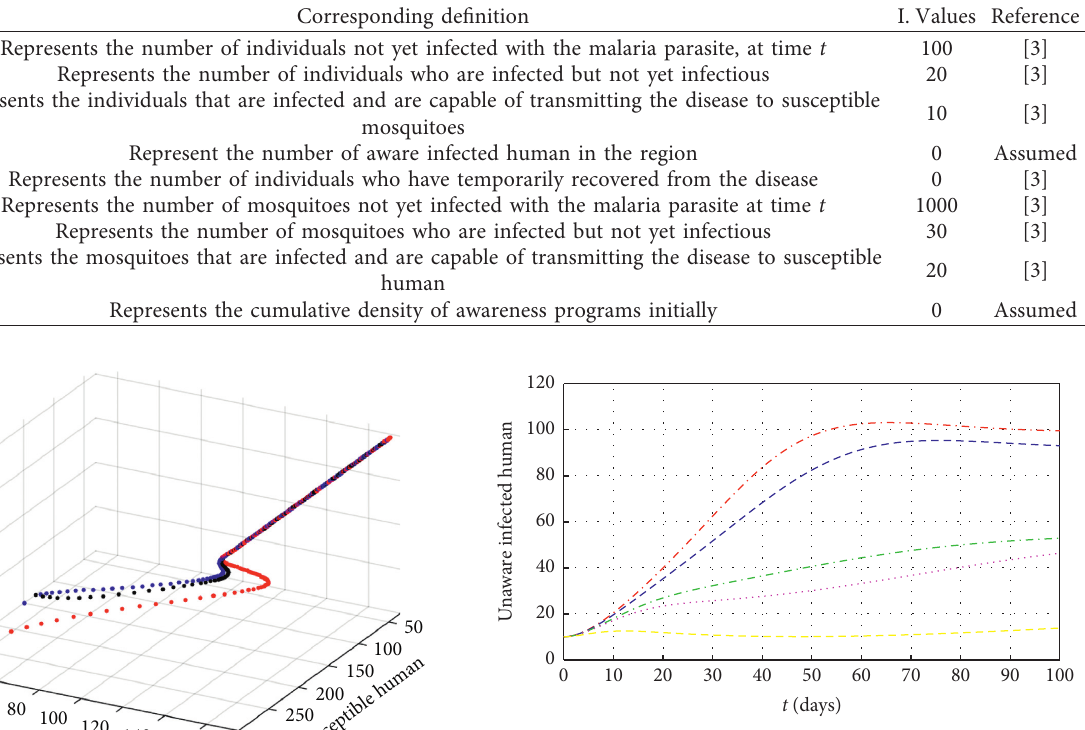
Figure 4: Population of unaware infected humans with and without awareness, (without awareness (red line); with low to high awareness rate awareness (blue, green, magenta, and yellow line)).